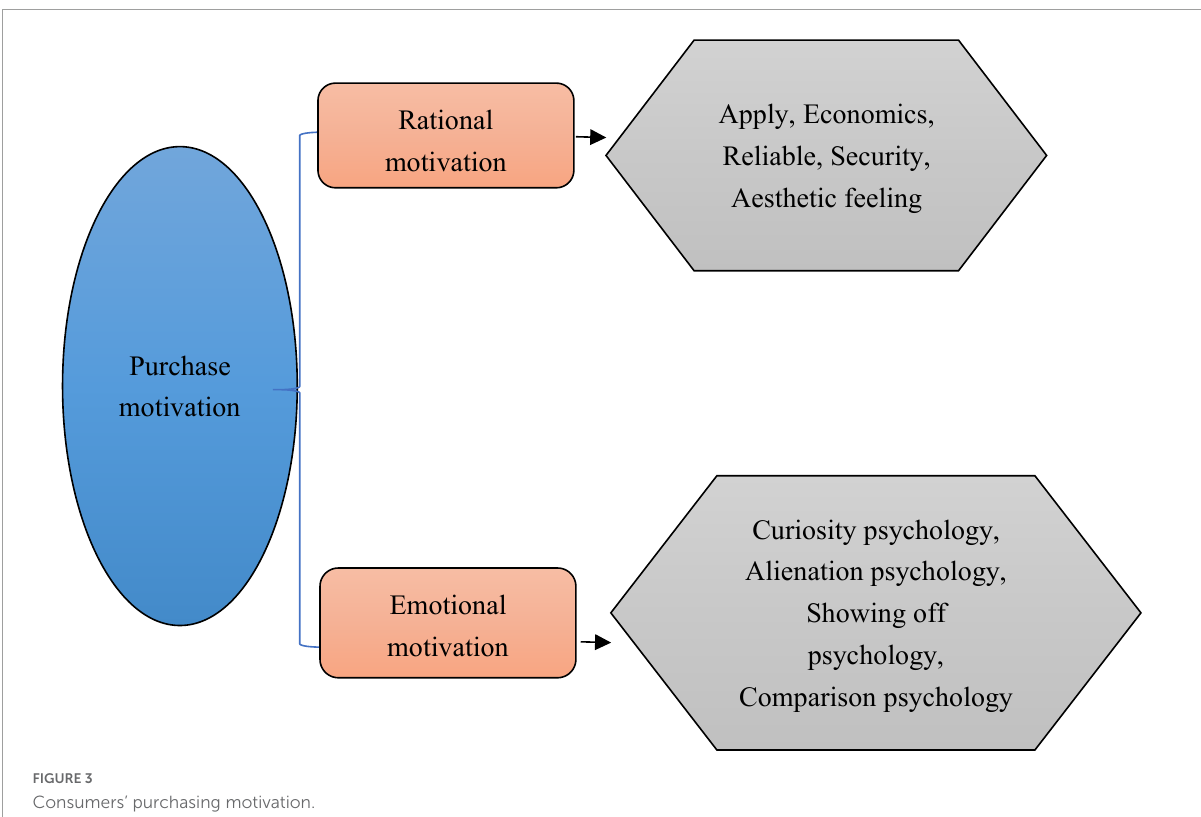
FIGURE3 Consumers’ purchasing motivation.